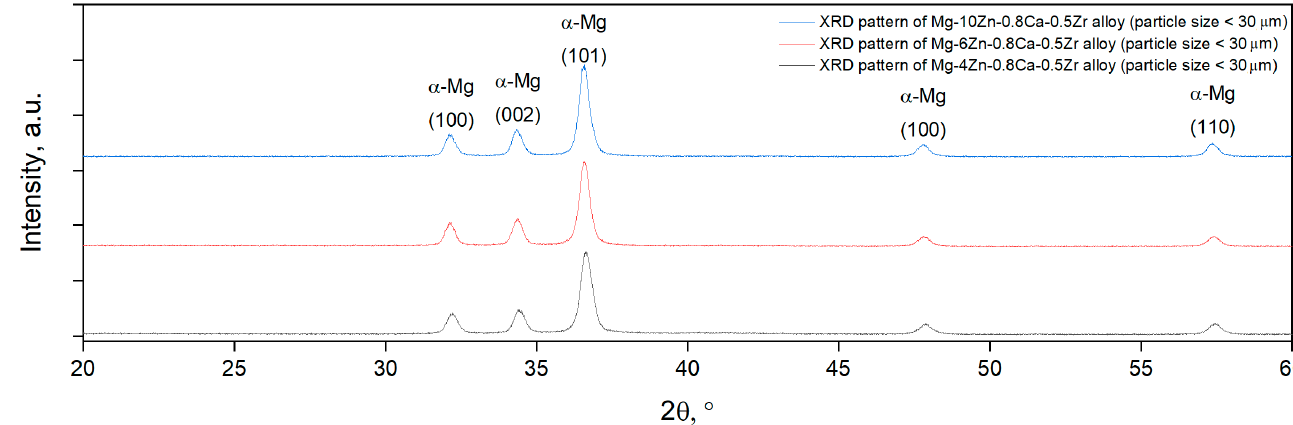
Figure 10. The XRD spectra for all three experimented powder-compositions of Mg-xZn-0.8Ca-0.5Zr (wt.%) alloy (particle size < 30 μ m).